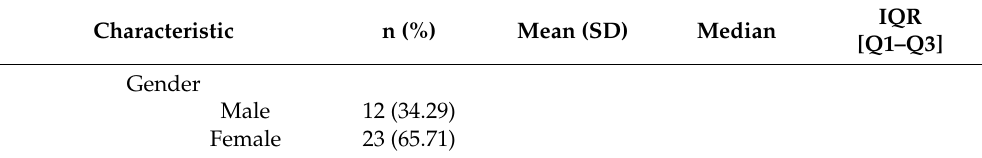
Table 1. Characteristics of participants (N =